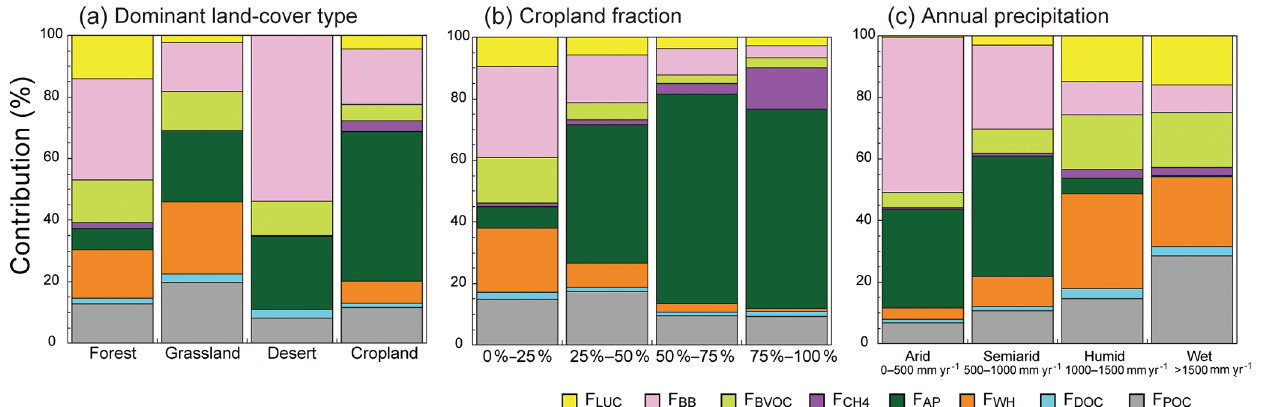
Figure 8. Relative contribution of MCFs to the terrestrial carbon budget simulated by EX ALL in 2000–2009: (a) aggregated by dominant land-cover type, (b) aggregated by cropland fraction within grid cells, and (c) aggregated by annual